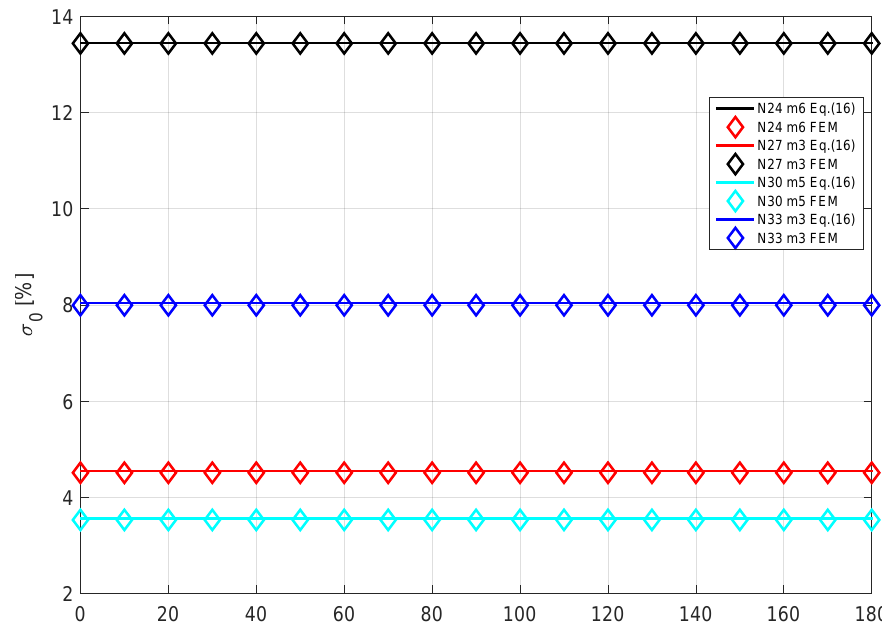
Figure 13. FEM validation for symmetrical Goerges polygons